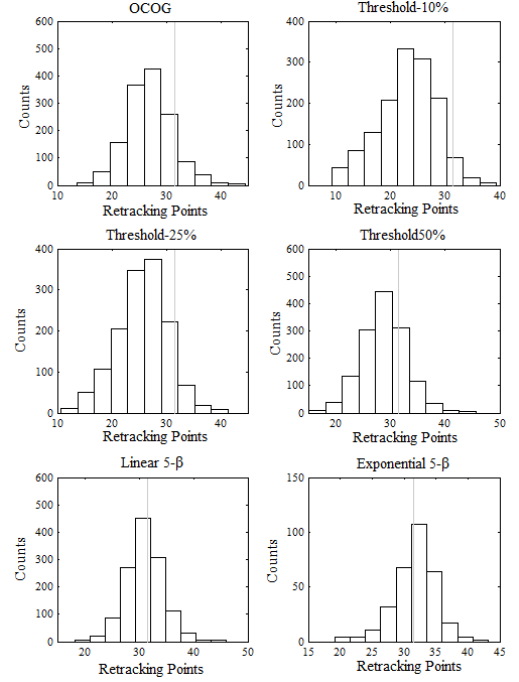
Figure 4. Histograms of retracking results for LRM waveforms, the gray line indicates the pregiven gate.